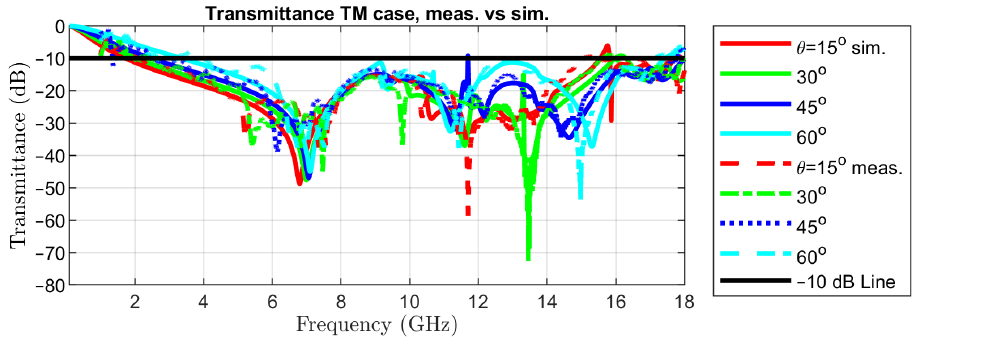
Figure 11. Transmittance in oblique incidence of TM waves: simulated vs. measured.